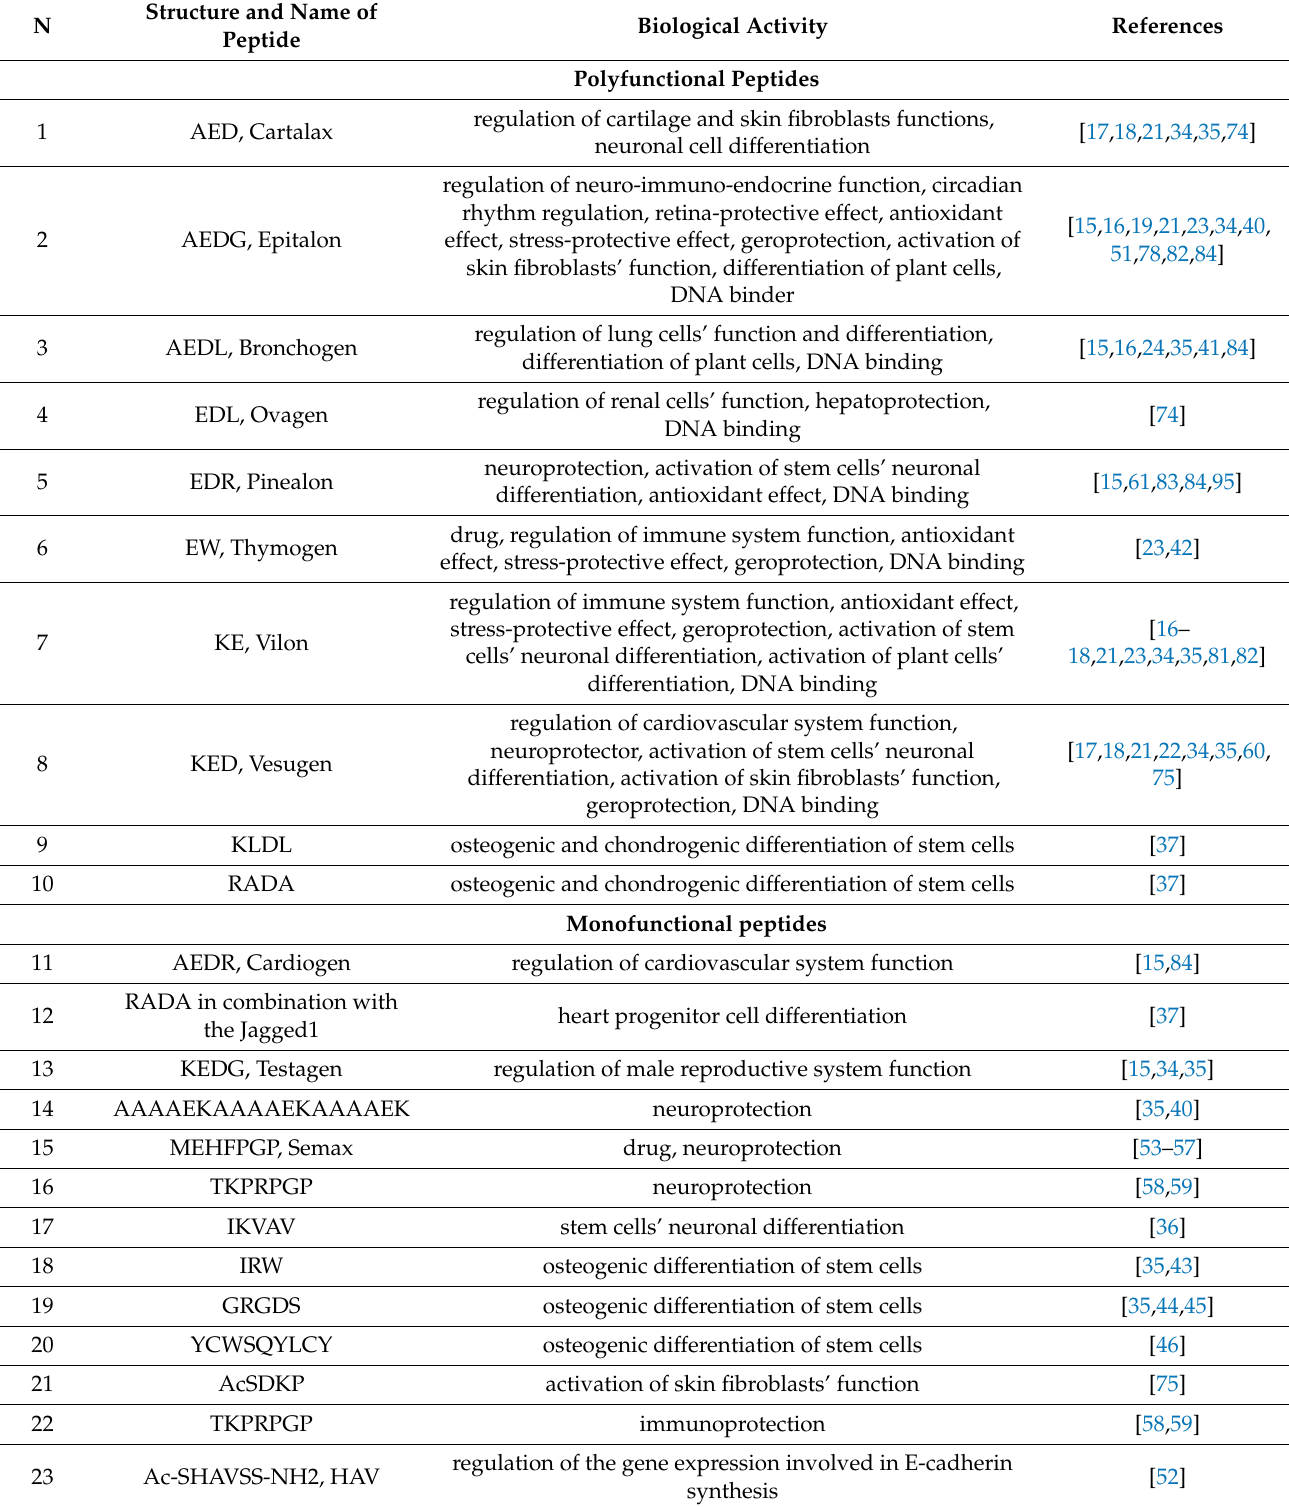
Table 5. Biological effects of the short